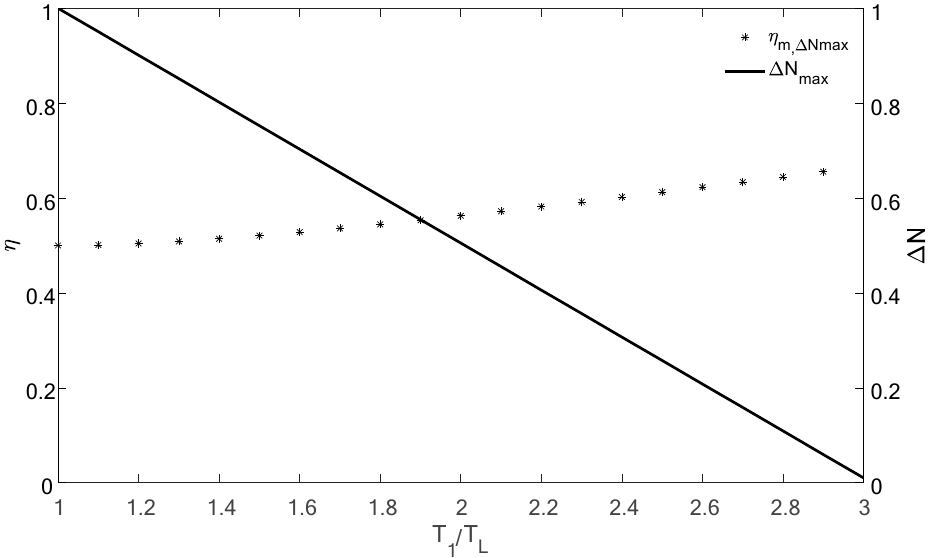
Figure 5. Efficiency and optimal mass conversion from high to low chemical potential in the chemical engine as a function of T 1 / T L .